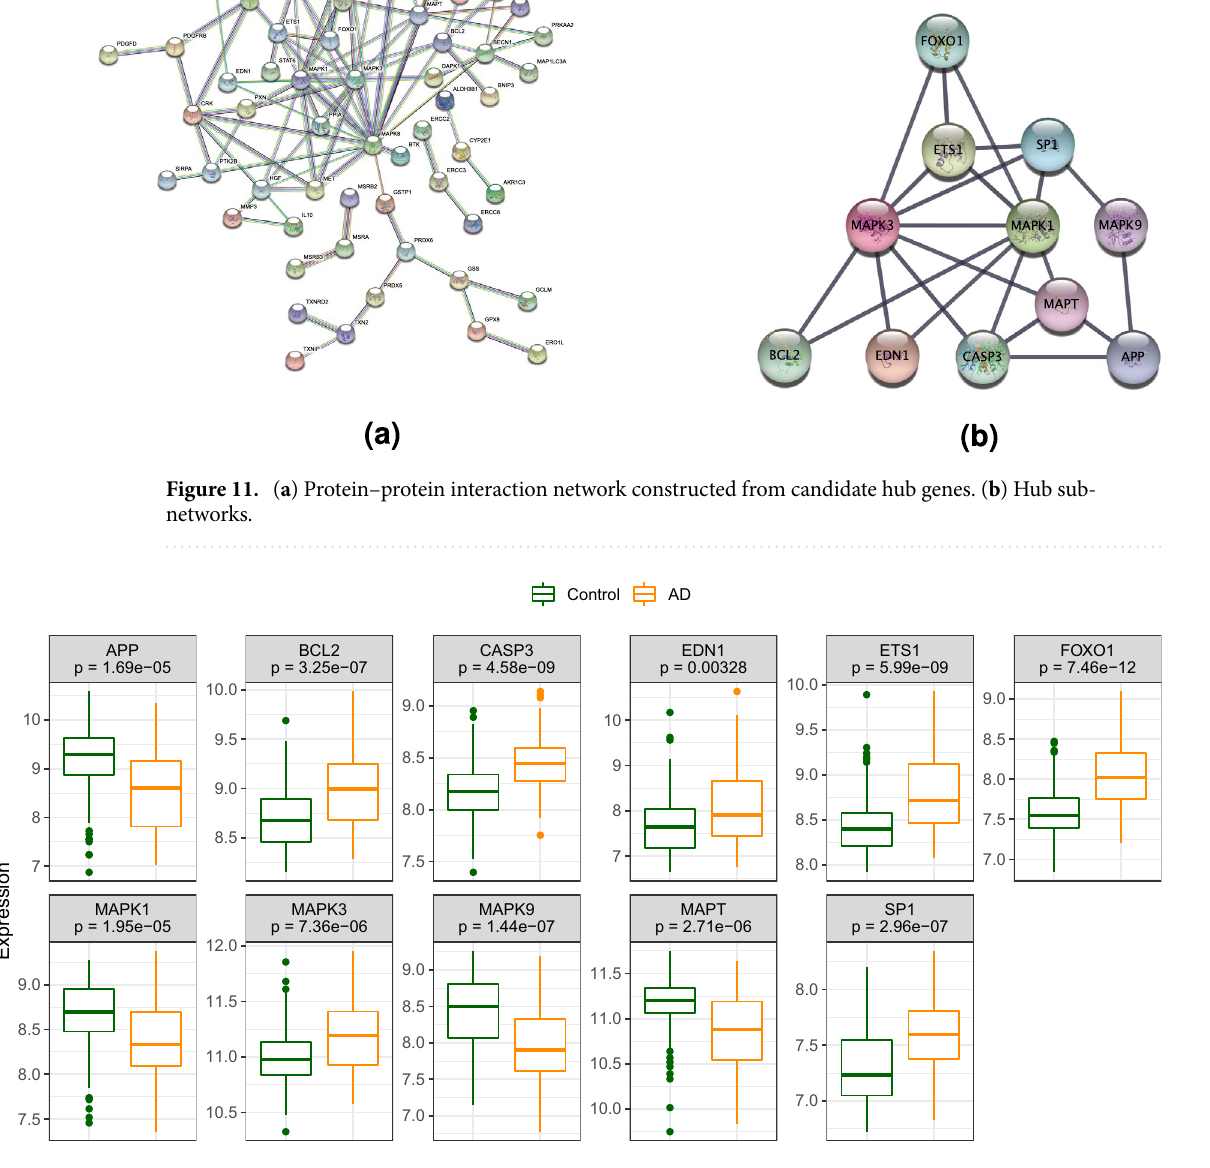
Figure 12. Expression levels of candidate hub genes in patients and matched